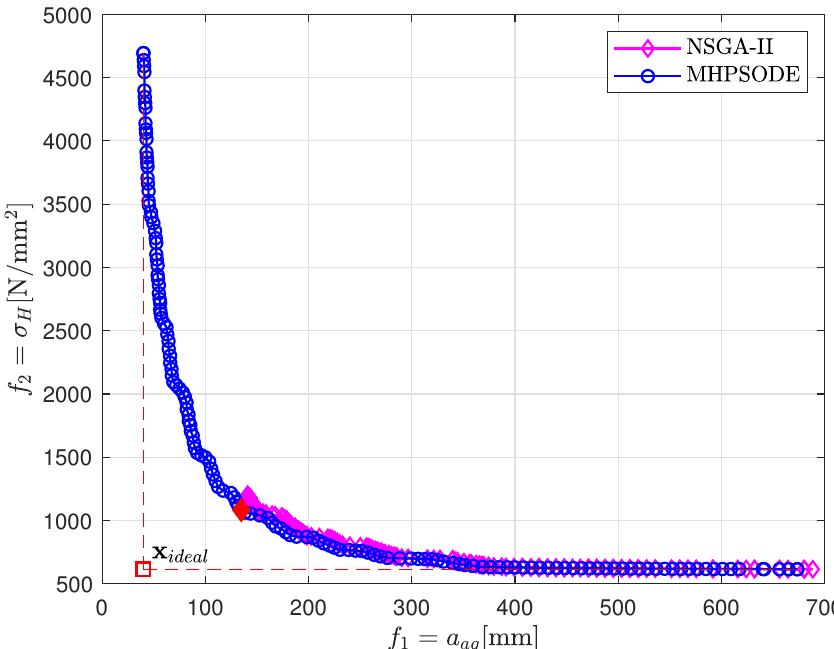
Figure 5. The obtained Pareto frontier for the center distance and contact stress σ H as objectives.